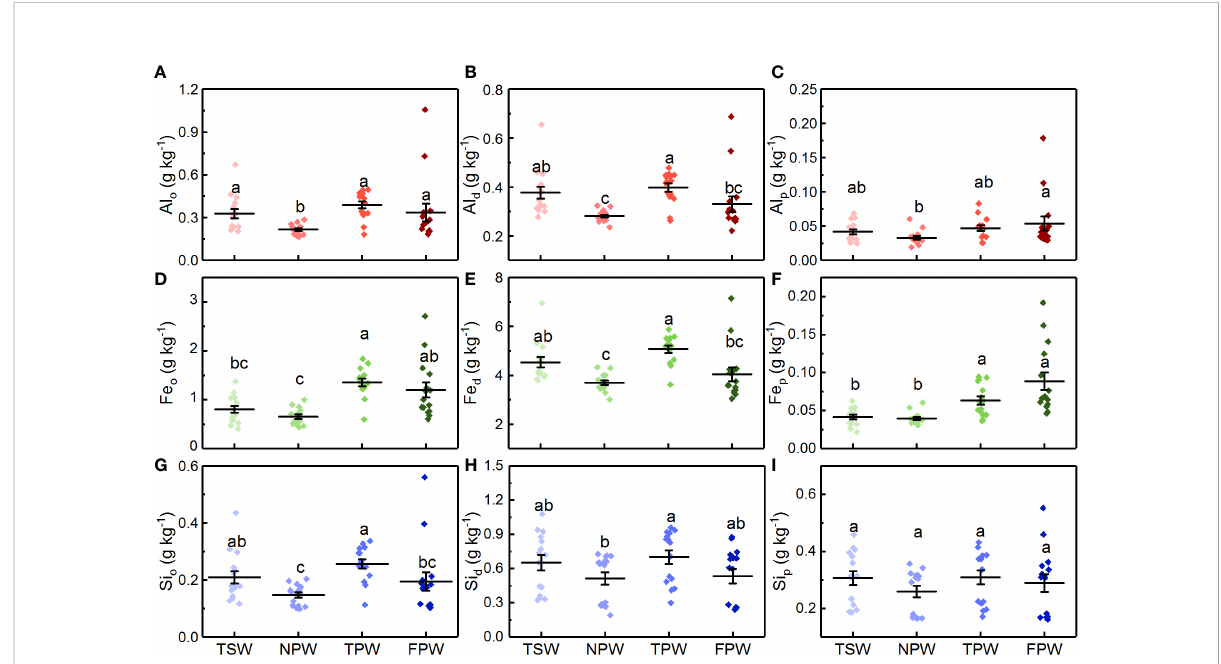
FIGURE 4 Comparison of Al o (A) , Al d (B) , Al p (C) , Fe o (D) , Fe d (E) , Fe p (F) , Si o (G) , Si d (H) and Si p (I) contents in the four wetlands. (Different lowercase letters represent signi fi cant differences between the same layers of the four wetlands at p < 0.05 level).